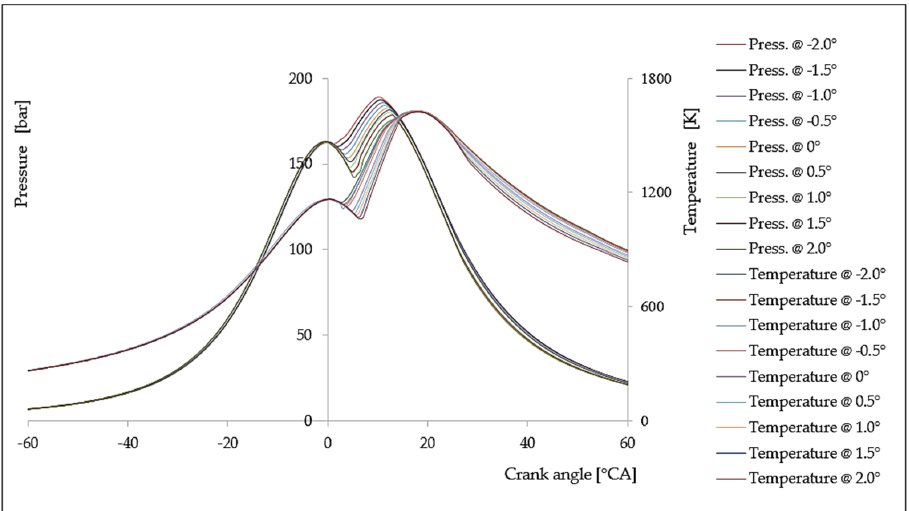
Figure 5. Dependence of pressure and combustion temperature changes due fuel injection timing changes [22].